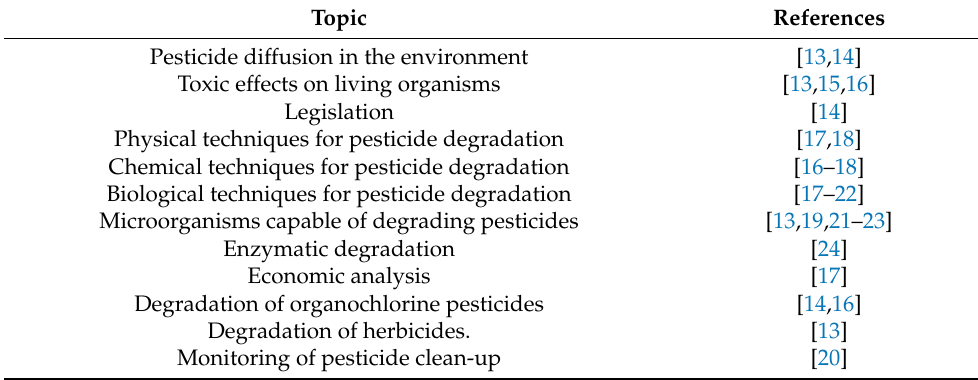
Table 1. Reviews on